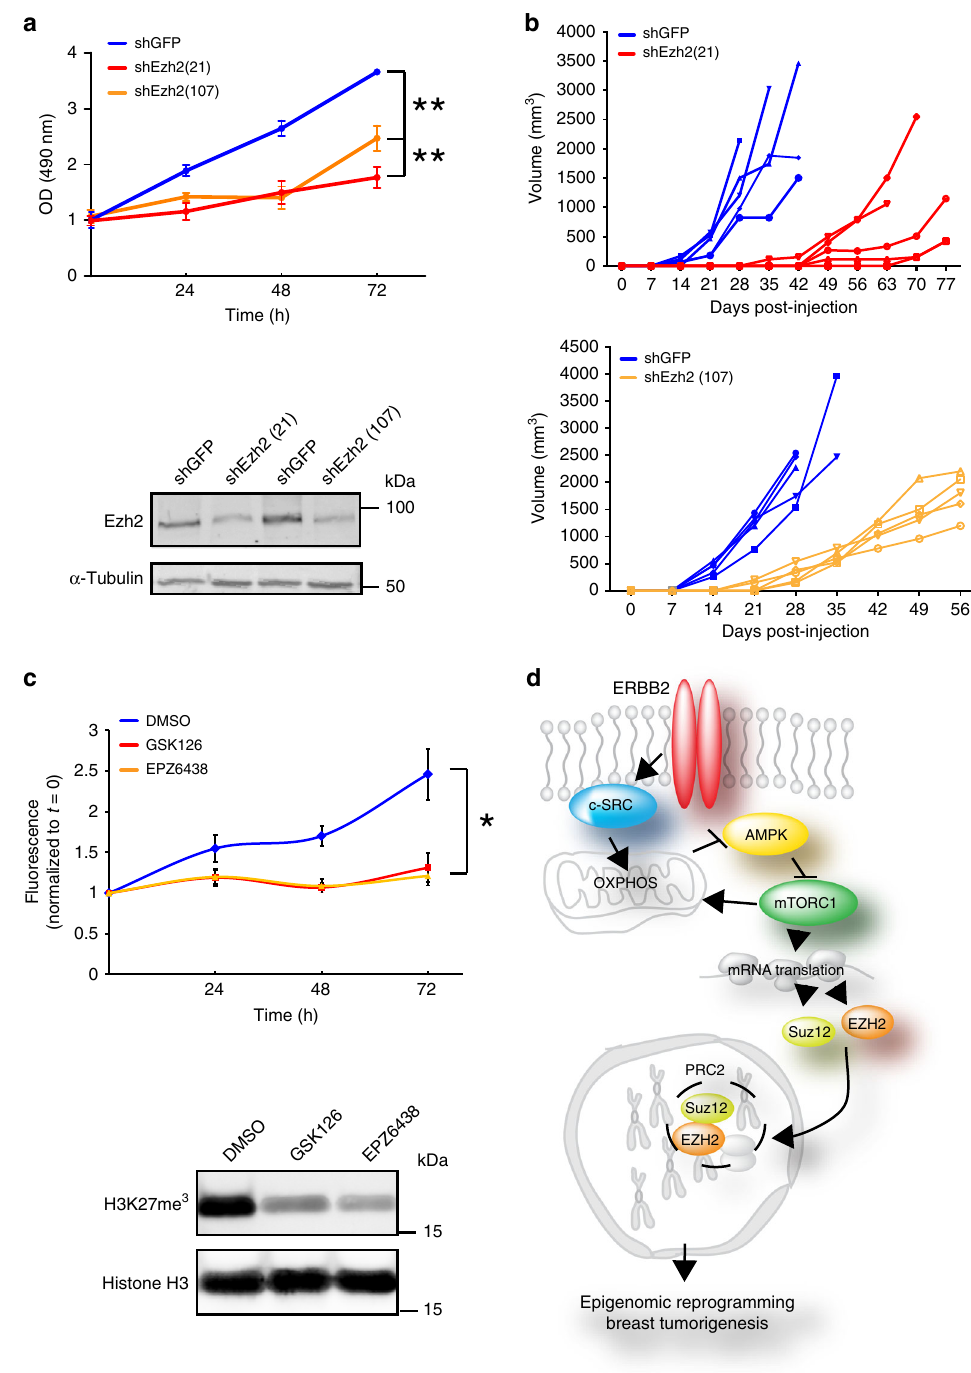
Fig. 9 Ezh2 silencing or inhibition inhibits ErbB2 + mammary tumor cell growth. a Ezh2 expression was silenced in an established ErbB2-driven breast cancer cell line derived from the NIC model using lentiviral shRNA (pLKO.1 shEZH2(21)) and pLKO.1 shEZH2(107). An shRNA targeting GFP was used as a negative control. Top panel shows a representative cell growth assay (mean ± SEM, ** = p < 0.01; One-way ANOVA with Dunnett ’ s post-test). Bottom panel is a representative immunoblot showing silencing of Ezh2. b Cells as in a were injected into the mammary fat pads of athymic nude (NCr) mice. Tumor outgrowth was monitored by palpation and caliper measurement. c Upper panel shows proliferation of ErbB2-positive MMTV-NIC breast cancer cell lines treated with the EZH2 inhibitors GSK126 and EPZ6438 ( n = 4 cell lines derived from independent tumors, DMSO vs. GSK126, p = 0.038; DMSO vs. EPZ6438, p = 0.029; one-way ANOVA with Tukey ’ s post-test). Lower panel is a representative immunoblot showing inhibition of H3K27 tri-methylation. d Schematic diagram illustrating c-Src-dependent regulation of PRC2 components via modulation of OXPHOS and mRNA